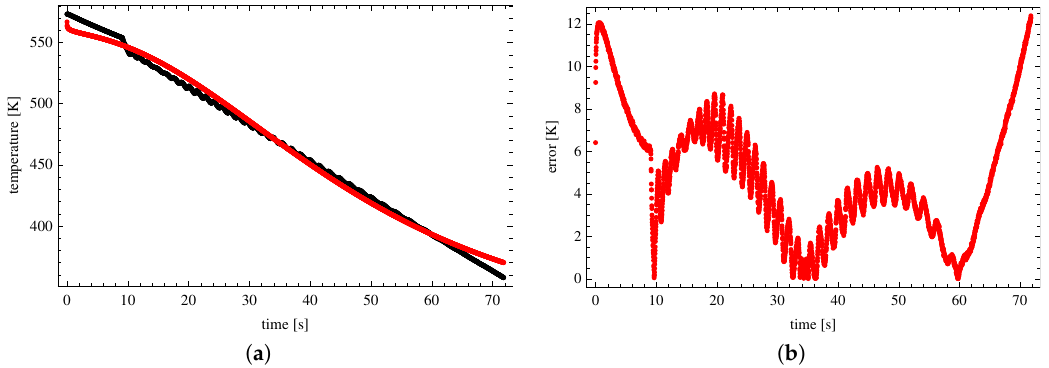
Figure 3. ( a ) Measurements of the temperature (black line), reconstructed temperature (red line); and ( b ) distribution of errors for this reconstruction (100 ×